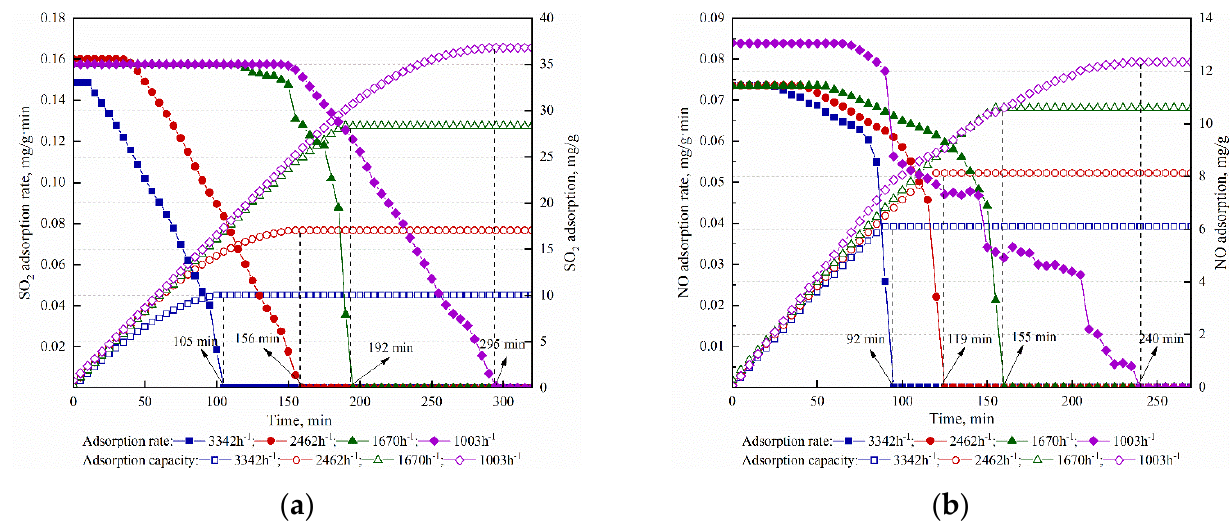
Figure 10. ( a ) The effect of space velocity on SO 2 adsorption performance; ( b ) the effect of space velocity on NO adsorption